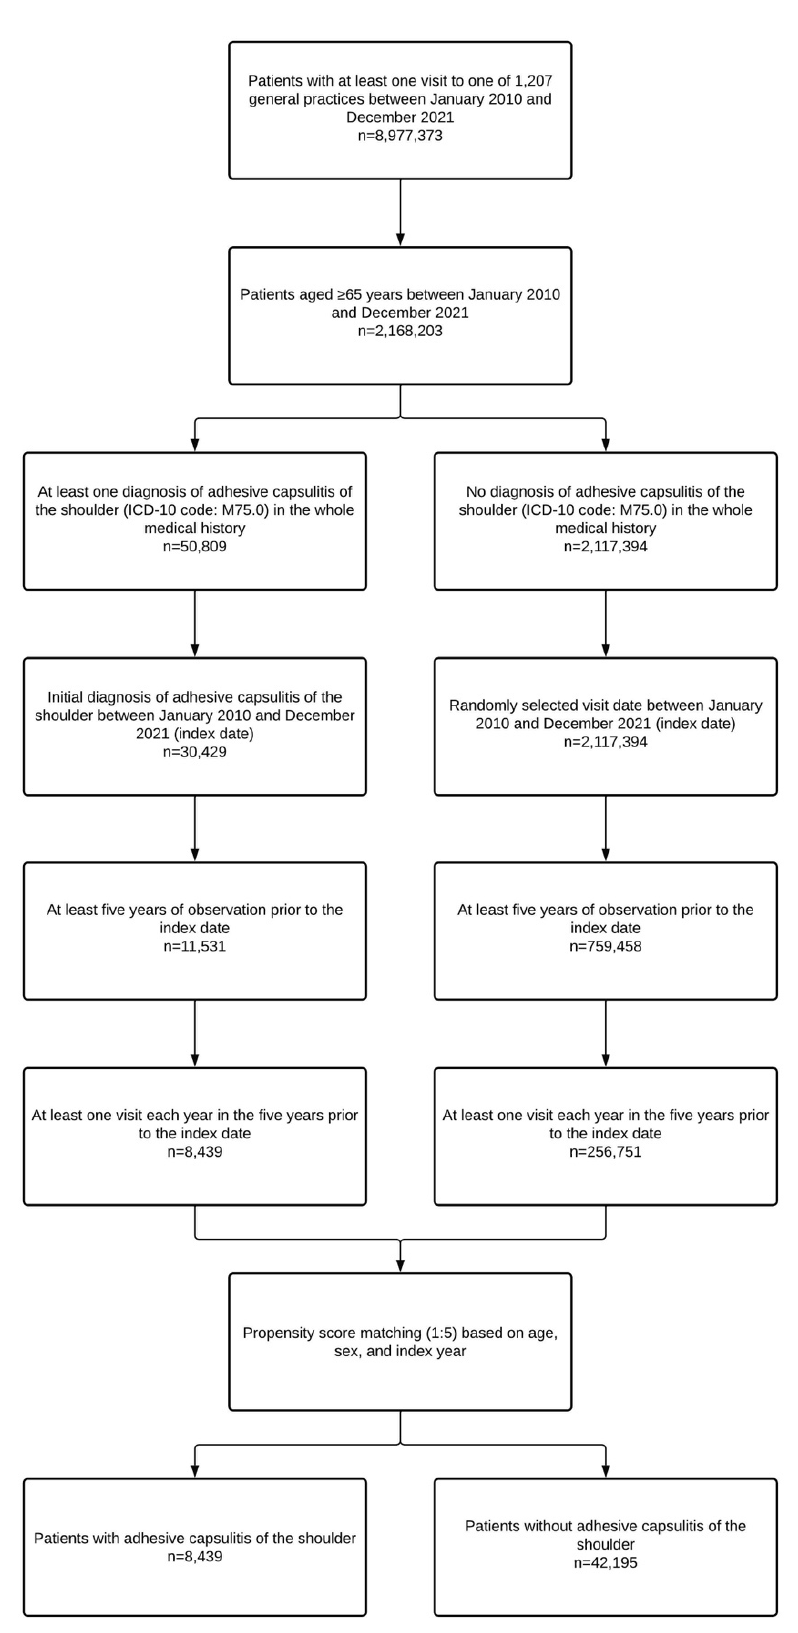
Figure 1. Flow diagram of study patients. Abbreviation: ICD-10, International Classification of Diseases, 10th